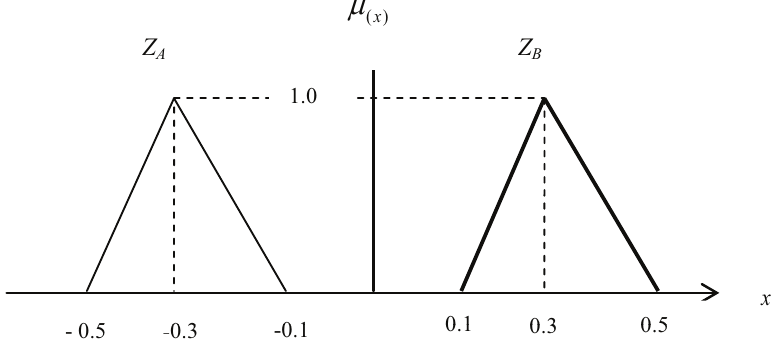
Fig 7.Z – fuzzy numbers Z A and Z B of Case 4.